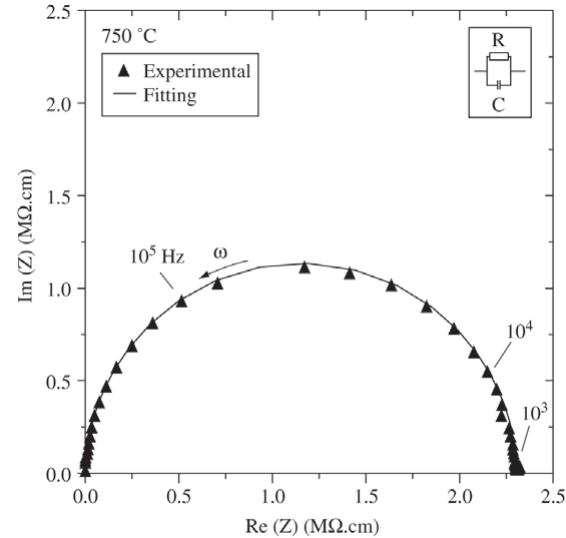
Figure 1. Complex impedance diagrams of Bi tal, taken isothermally at 600, 650, 700 and 750 °C. The numbers indicate the signal frequency.